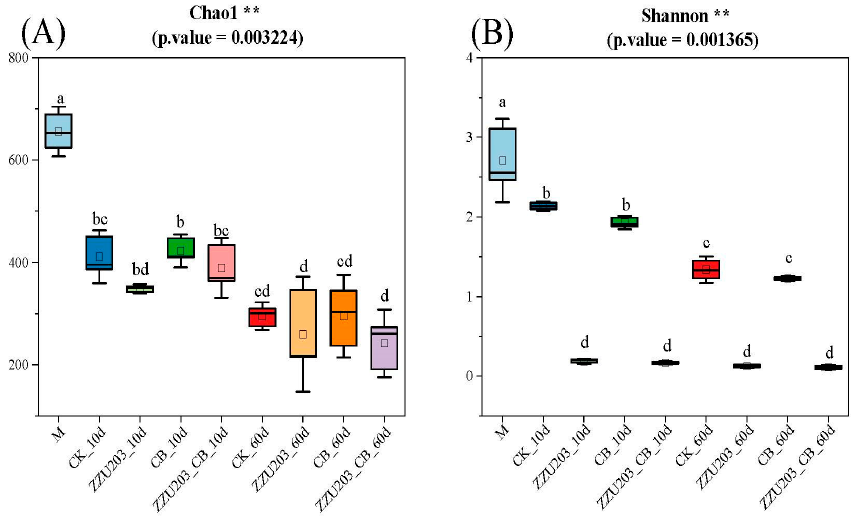
Figure 4. Box-plots of Chao 1 ( A ) and Shannon indices ( B ) of bacterial communities in alfalfa silage. Values with different small letters indicate significance over groups illustrated via absolute quantification 16S-seq (AQS; ** p < 0.01).